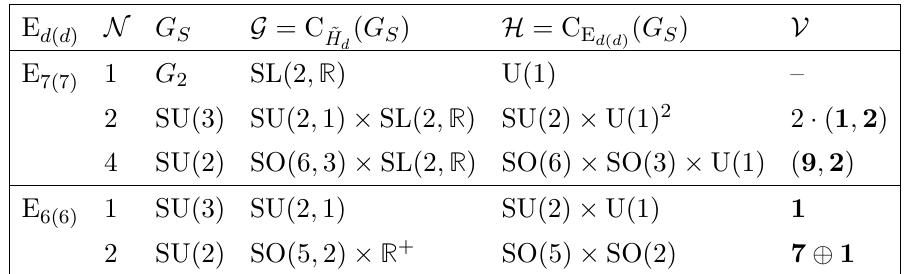
Table 4 . Commutant groups and G -representations of the vector (cid:12)elds for consistent truncations using conventional G